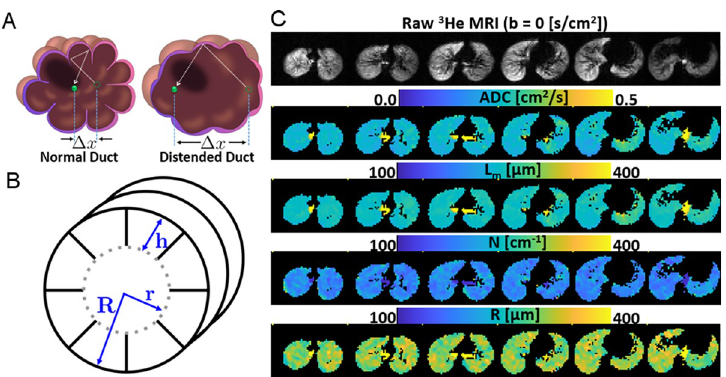
Fig 1. HHe MRI overview. (A) Schematic of a single HHe atom that is measured at to sequential time points. In a normal alveolar duct (top), although the atom diffuses the same total distance (dashed line) measurement is limited to the measured distance ( Δ x ) and is relatively small. In dilated ducts, diffusion is less restricted and Δ x is larger. (B) Schematic representation of the outer alveolar duct radius (R), the inner duct radius (r), and the septal height (h). (C) Representative axial images of the raw HHe data (top), directly measured apparent diffusion coefficients (ADC), calculated mean linear intercept (L m ) values, derived alveolar density (N) values. Manual segmentation of right and left lung values was performed to obtain unilateral values for right-left comparisons.